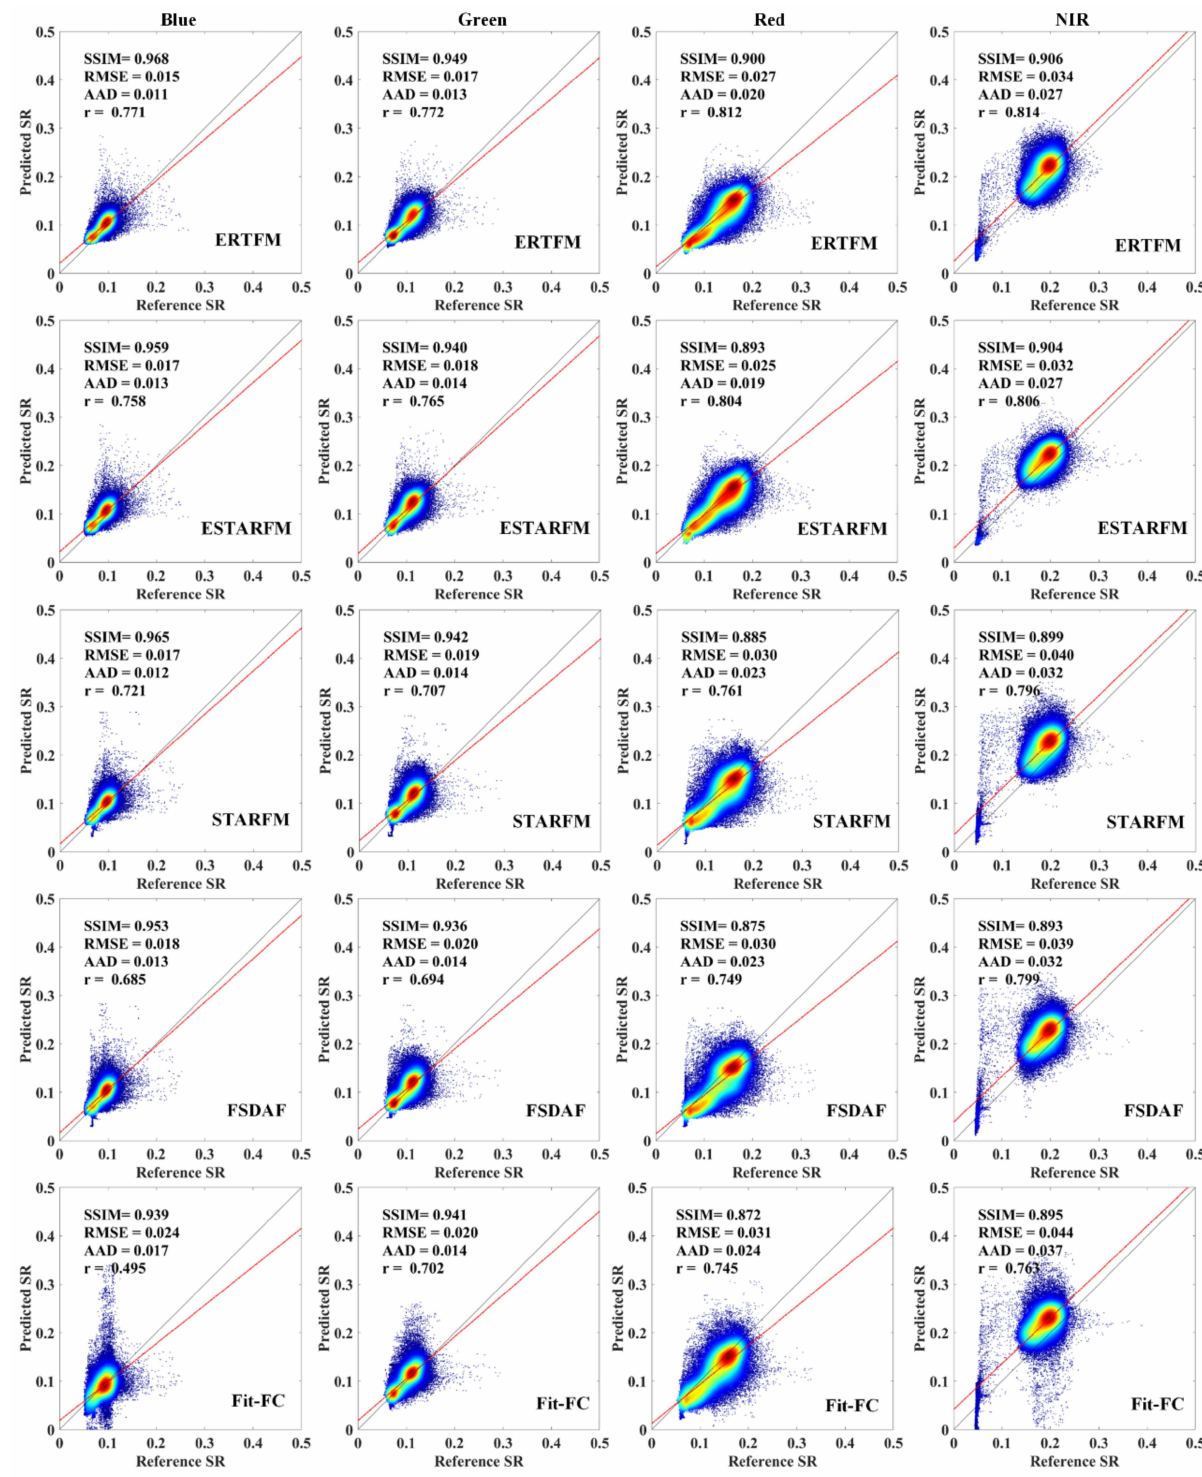
Figure 7. Scatter plots of observed GF-1 reflectance and predicted reflectance by ERTFM, ESTARFM, STARFM, FSDAF, and Fit-FC. The red line is the fitting line and the black line is the 1:1